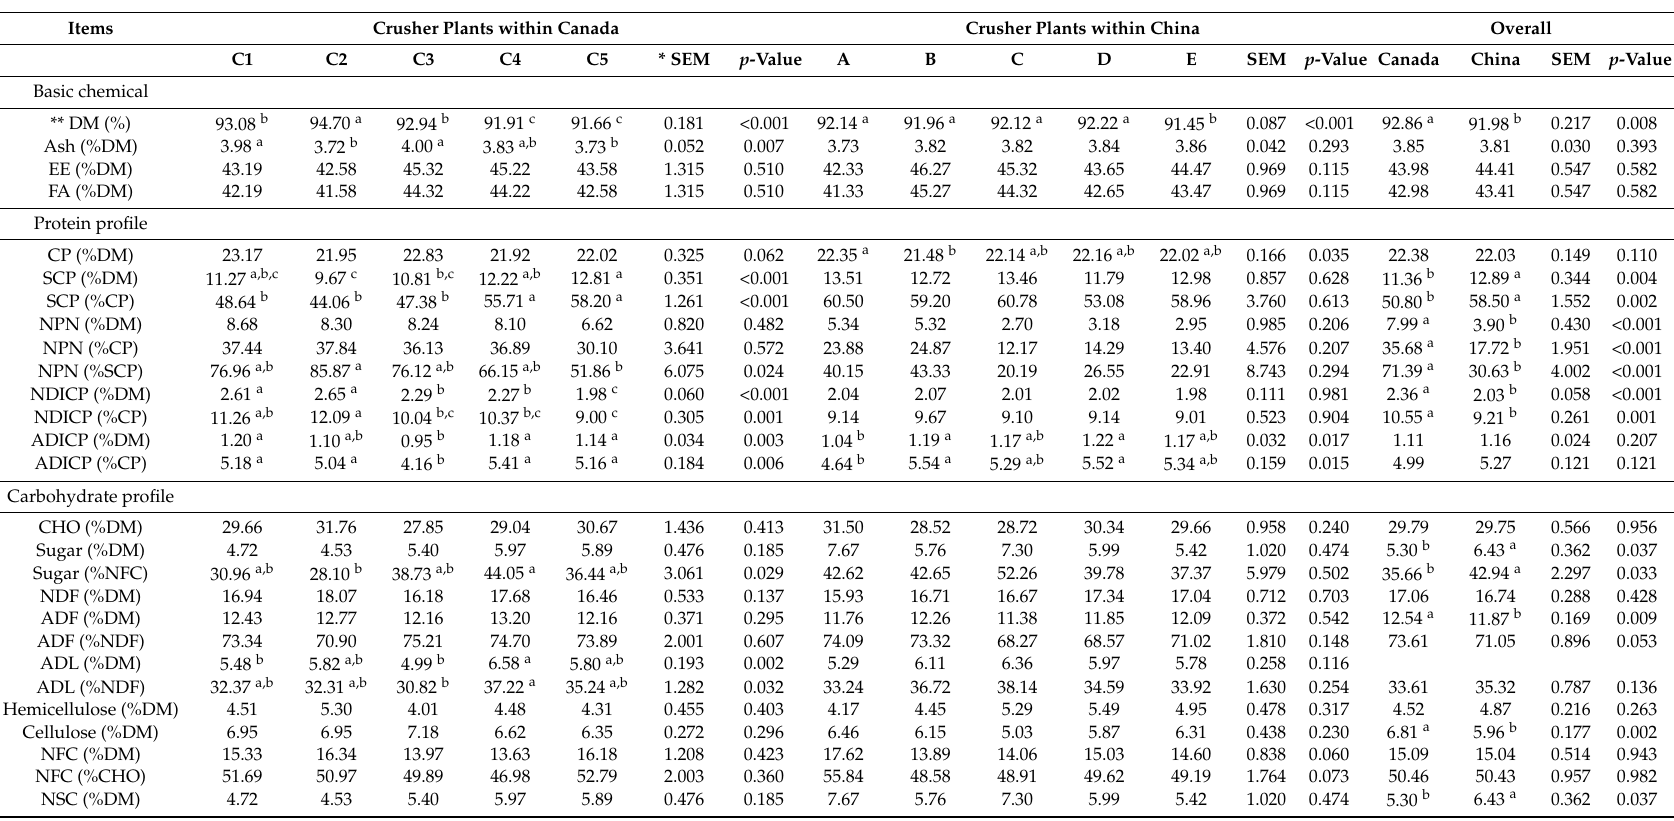
Table 1. Bioactive compounds, anti-nutritional factors, and chemical composition of oil-seeds from bio-oil processing (canola seeds): Comparison of crusher plants within Canada and within China as well as between Canada and